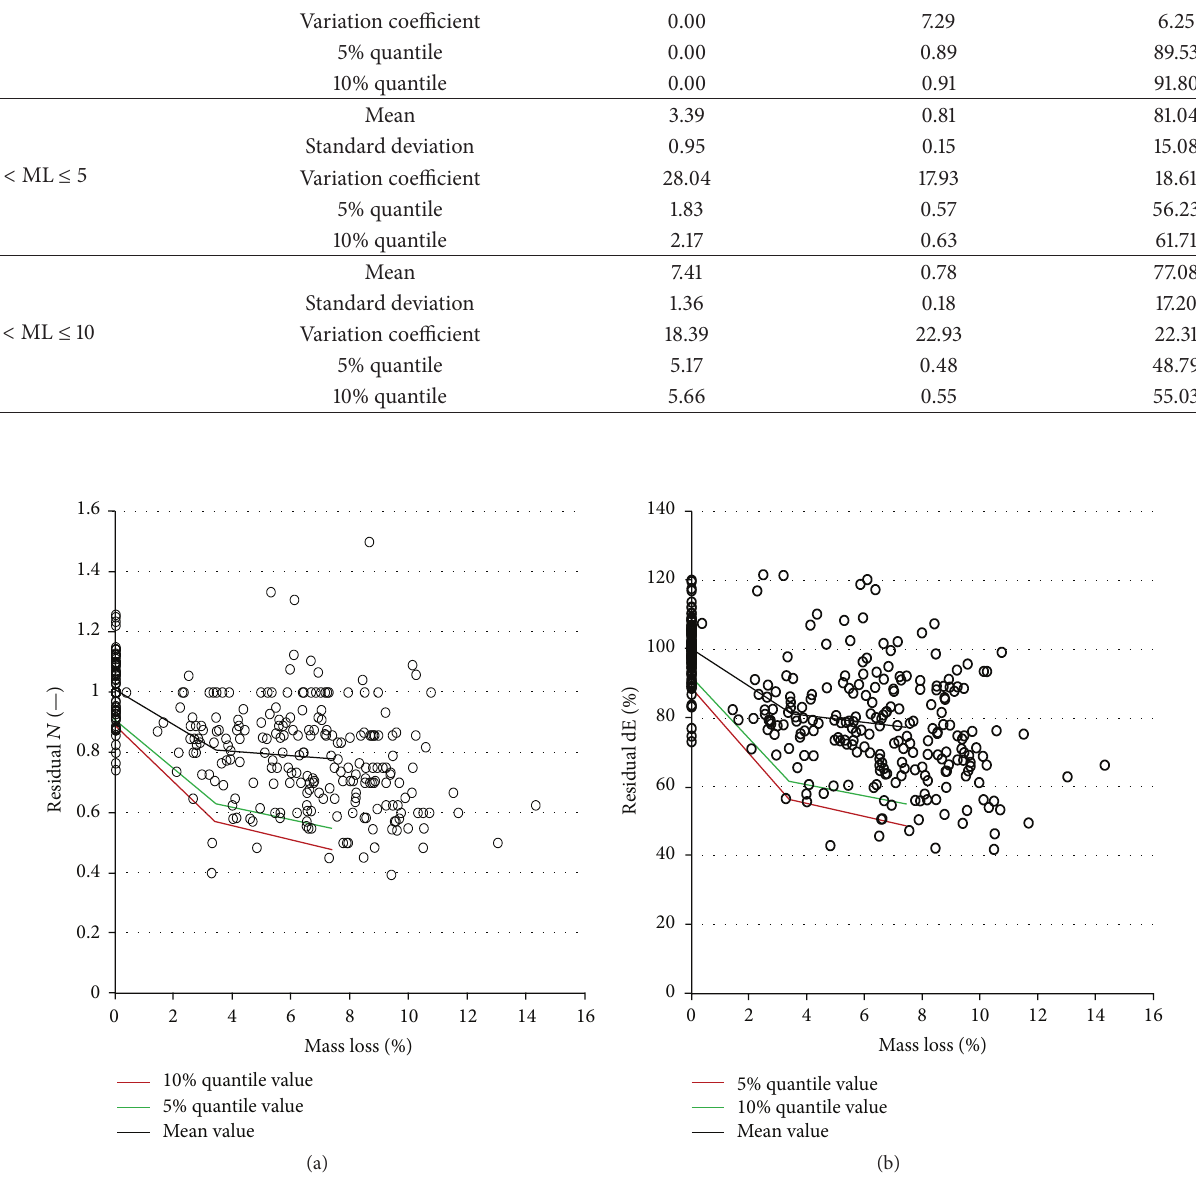
Figure 15: (a) Scatterplot for res. N versus mass loss and quantile slopes for res. N . (b) Scatterplot for res.dE versus mass loss and quantile slopes for